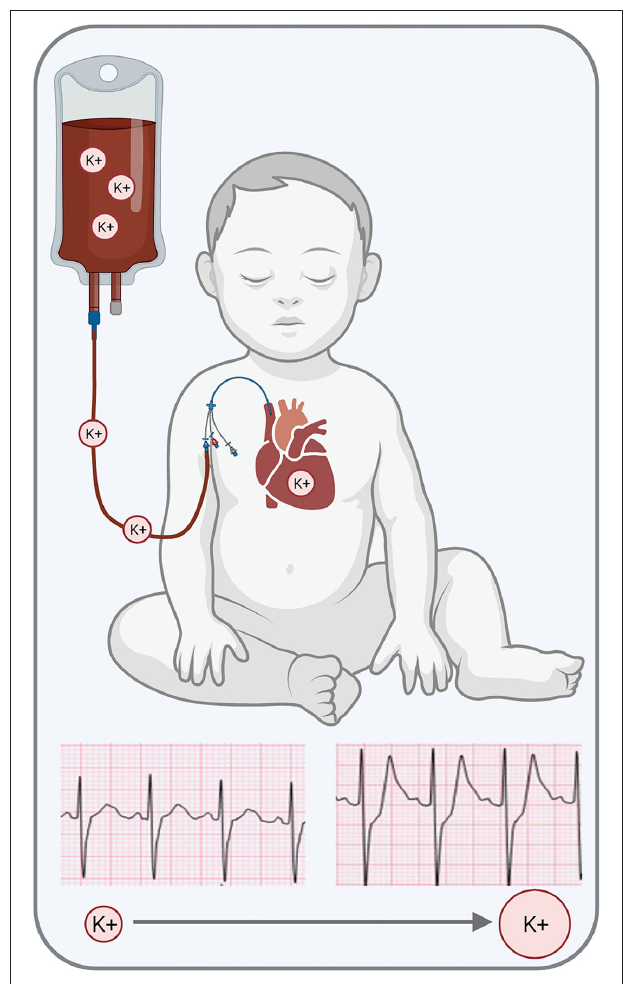
FIGURE 1 | Transfusion-associated hyperkalemia can precipitate cardiac electrical disturbances, which can present with peaked T -waves in the electrocardiogram. Further increase in serum [K + ] can result in cardiac arrest. Graphic generated in BioRender. ECG traces kindly provided by Dr. Elizabeth